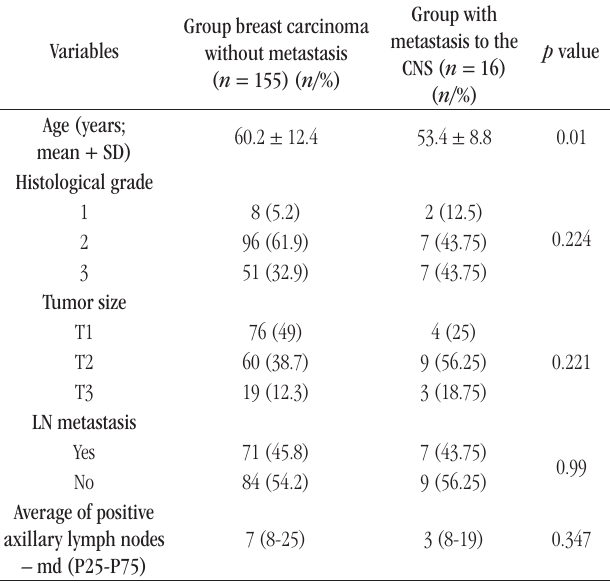
taBLE 1 – Breast invasive ductal carcinoma and brain metastases: relationship of age, histological grade, tumor size and metastases to axillary lymph nodes